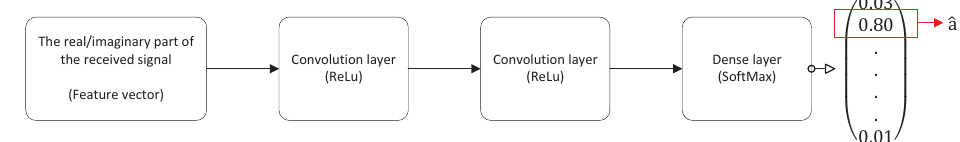
Figure 2. Block diagram of using CNN network structure to detect FTN